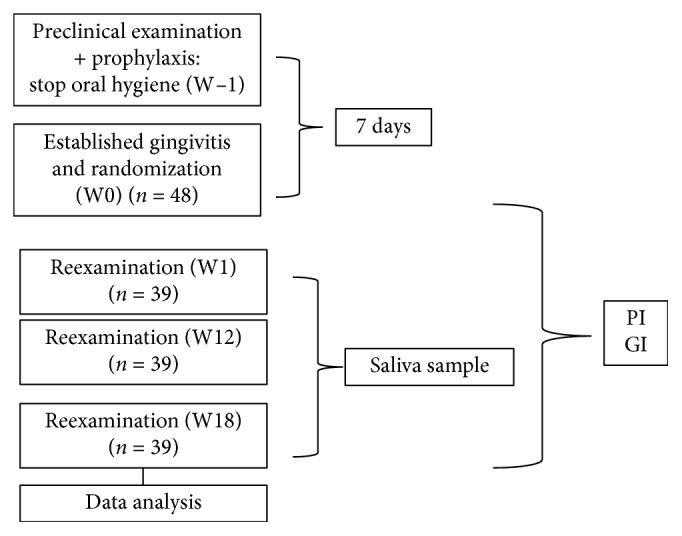
Experimental design.